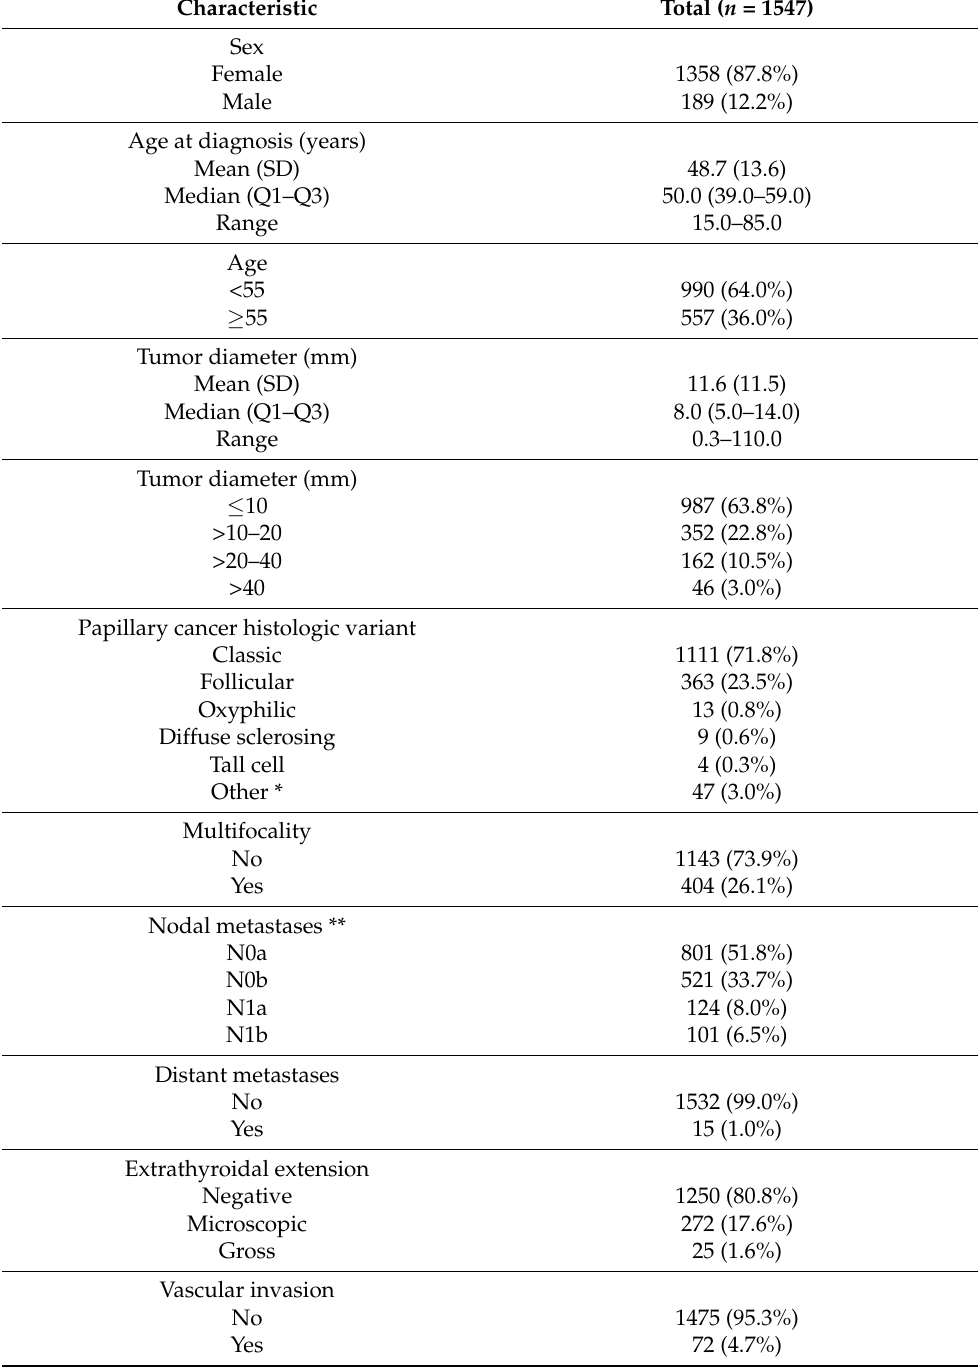
Table 1. Characteristics of the 1547 patients with papillary thyroid carcinoma